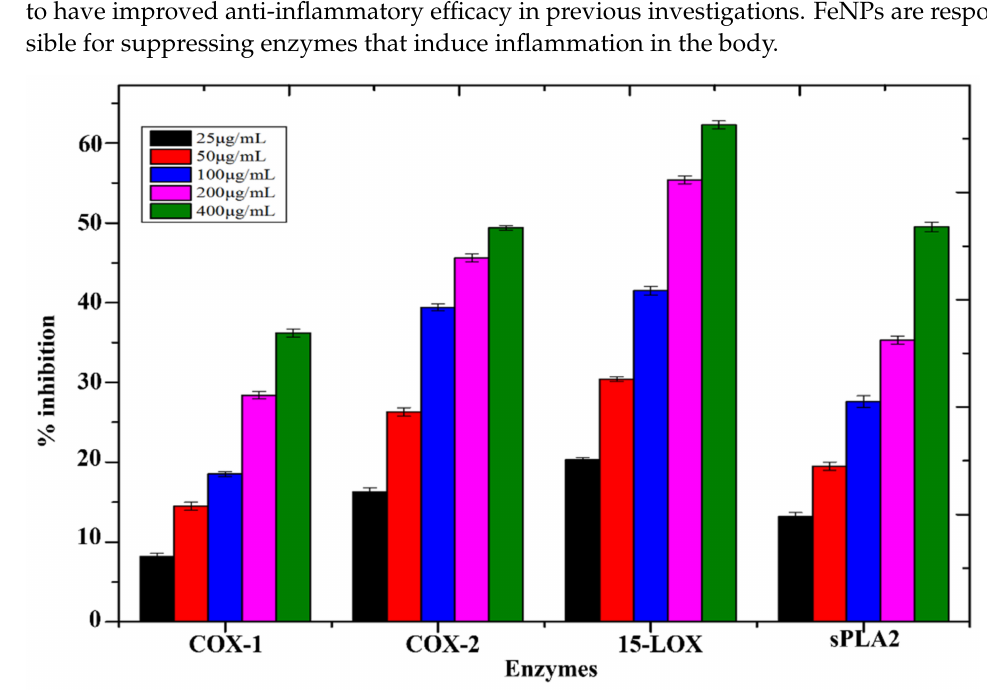
Figure 5. Anti-inflammatory potential of biosynthesized